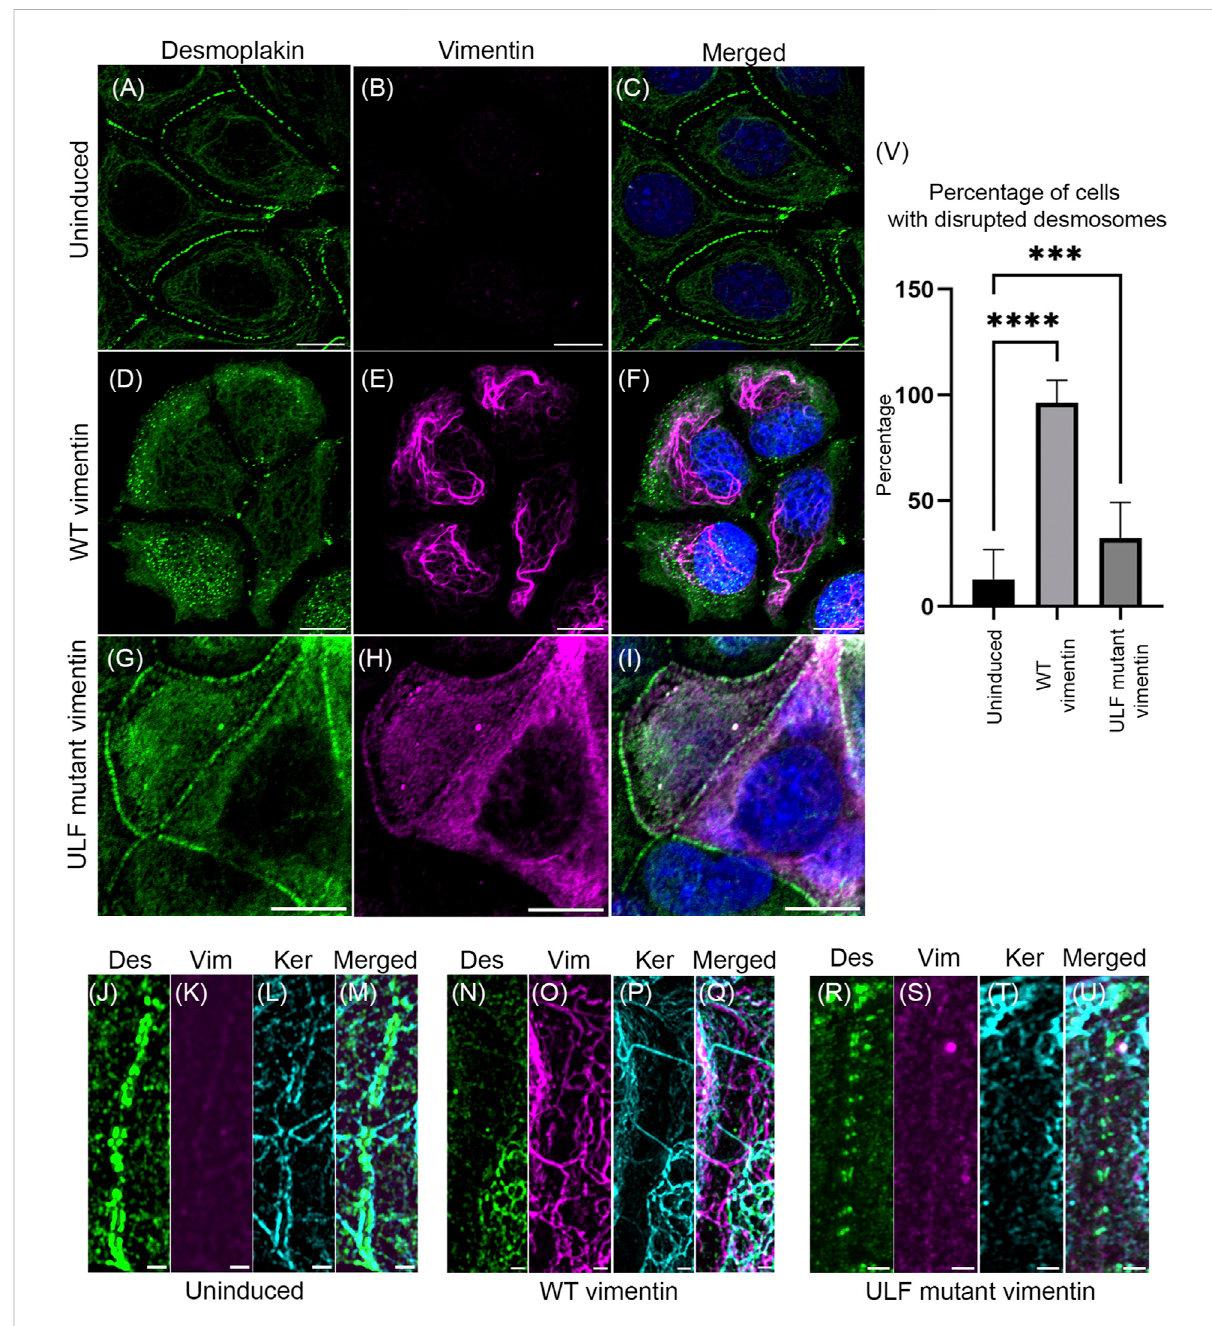
Expression ofvimentininMCF7disruptsdesmosomes.Immuno fl uorescenceimagesofdesmoplakin (A,D,G) andvimentin (B,E,H) inuninduced MCF7 (A,B,C) , cumate-induced MCF7 expressing WT vimentin (D,E,F) or ULF mutant vimentin (G,H,I) . Figures C, F and I show the overlay of desmoplakin and vimentin in the respective cells. Scale bar is 10 μ m. Structured Illumination Microscopy (SIM) images of desmoplakin (J, N, R), vimentin (K,O, S),and keratin(L,P, T) inuninducedMCF7cells (J – M) ,cumate-inducedMCF7 cells expressing WT vimentin (N – Q) and cumate- inducedMCF7cellsexpressingULFmutantvimentin (R – U) .FigureM,QandUshowtherespectiveoverlays. Scalebaris1 μ m. (V) Graphshowingthe percentageofcellshavingdisrupteddesmoplakininuninducedMCF7cells(N=205)andinMCF7cellsinducedtoexpresseitherWT(N=101)orULF mutant vimentin (N = 191). One way ANOVA was used to compare the differences between the groups.**** p < 0.0001; *** p < 0.001. All the experiments were done on cells sorted for GFP expression 5 days post induction with cumate (Des – desmoplakin; Vim – vimentin; Ker –